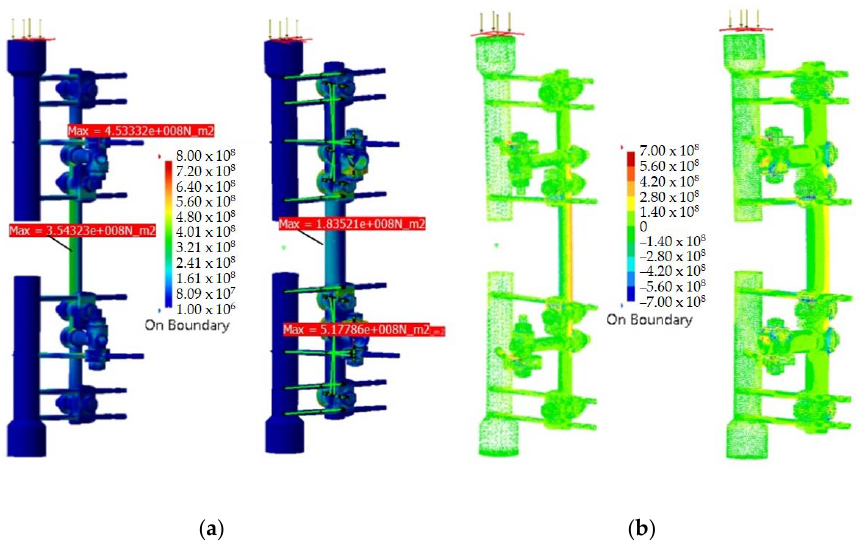
Figure 20. Distribution of von Mises stresses ( a ) and principal stresses ( b ) on initial and optimized design of the external fixation device.